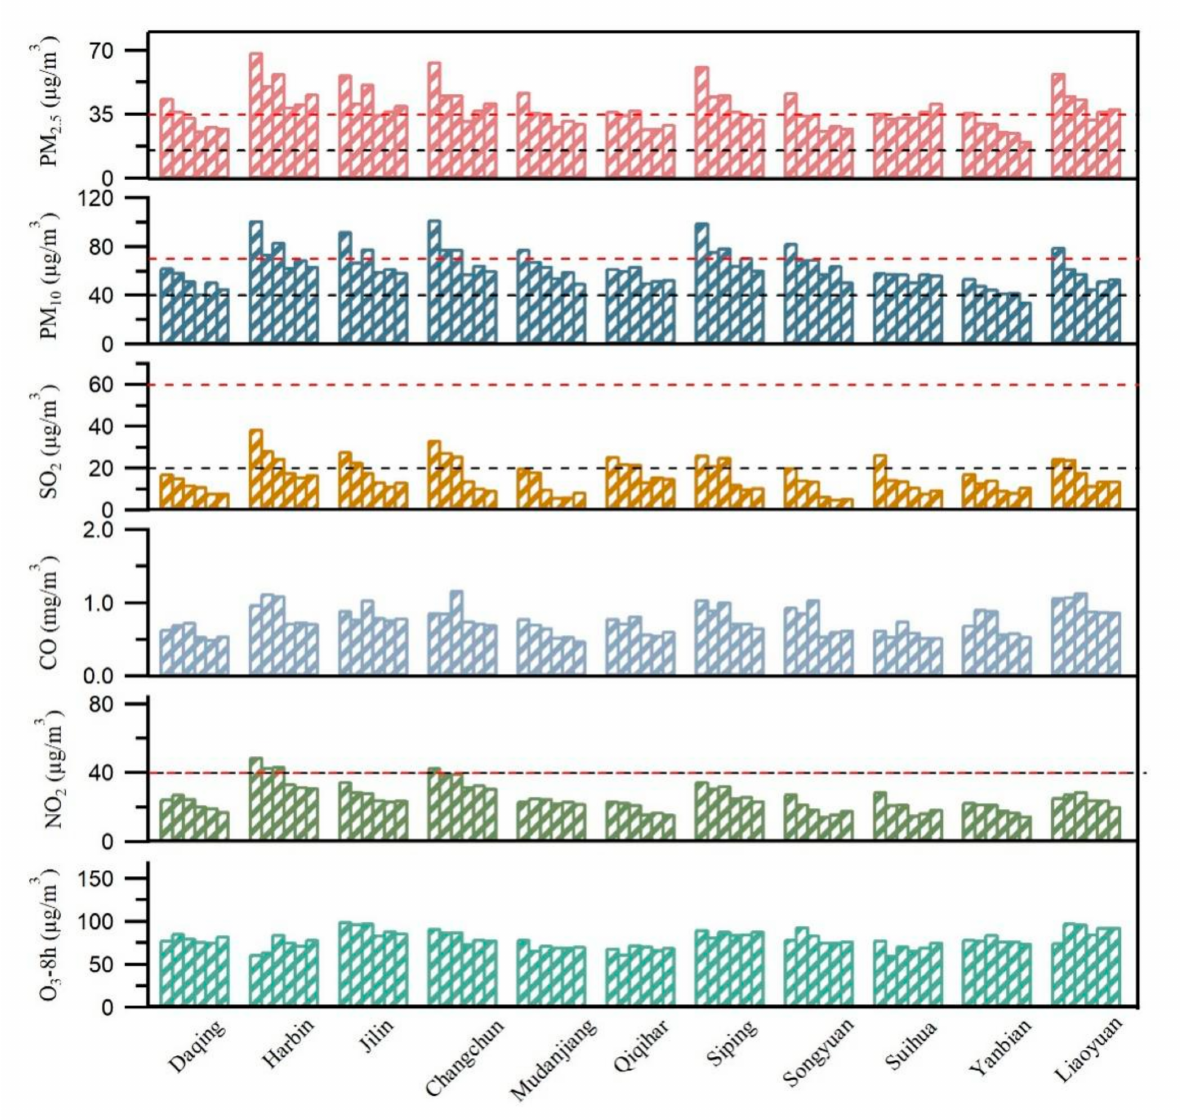
Figure 1. The annual average values of six pollutants from left to right in different cities represent the 2015–2020 period, respectively. The red dotted line represents Grade II standard and the black dotted line represents the Grade I standard according to the